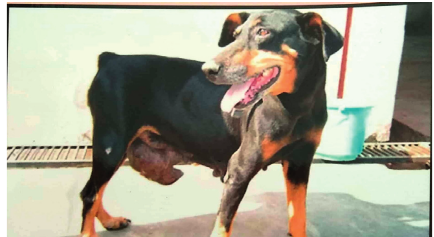
Figure 2: A one-year-old female Doberman having inguinal mammary tumor with cauliflower